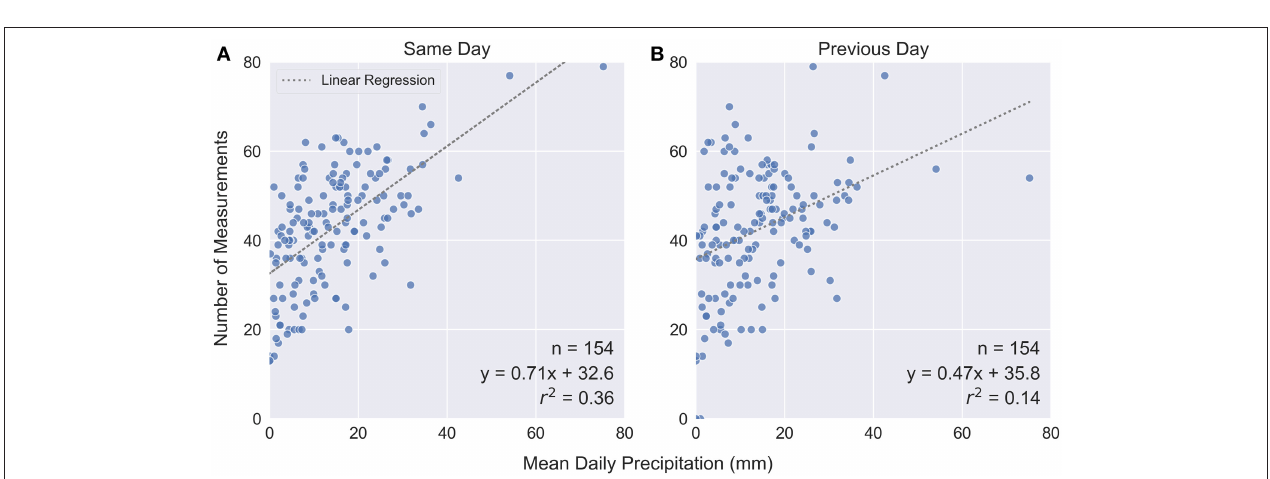
FIGURE 8 | Scatter plot of the number of measurements per day as a function of mean daily precipitation for the (A) same day and (B) previous day. Mean daily precipitation was taken as the average of all citizen scientists’ measurements. There were statistically significant correlations (Pearson’s r ) for the (A) same day ( r = 0.60; r critical = 0.21; alpha level = 0.01) and the previous day ( r = 0.38; r critical = 0.21; alpha level = 0.01).